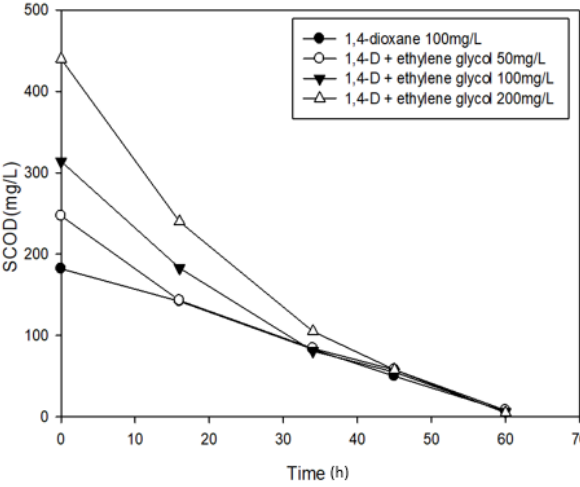
Figure 7. Soluble chemical oxygen demand (SCOD) degradation of 1,4-dioxane (1,4-D) and ethylene